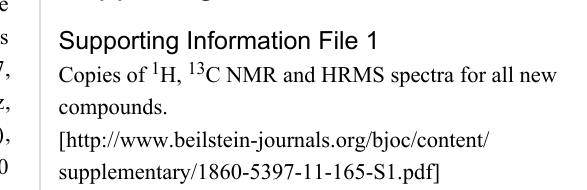
Compound 5: Pale yellow oil, 123 mg (75%), by using the general procedure 100 mg (0.36 mmol) of dione 3 was converted into diindole derivative 5 . IR (neat): 1048, 1097, 1242, 1374, 1447, 1465, 2927, 2974, 3019 cm − 1 ; 1 H NMR